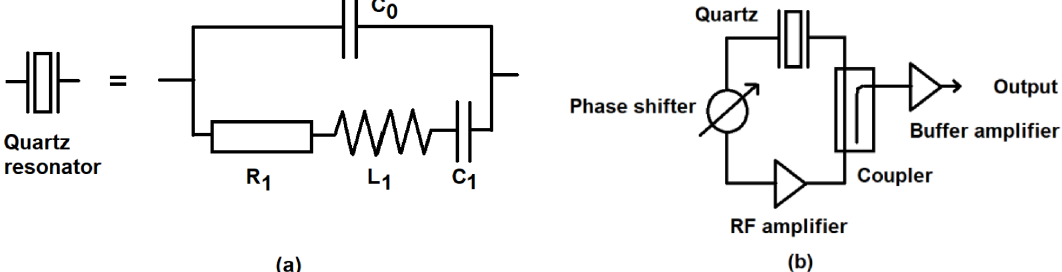
Figure 1. Principle of a quartz oscillator. A quartz crystal is equivalent to an electrical network with a low impedance in series and a parallel high impedance resonance. R1: resistance, L1: self, C0 and C1: capacitances. (a) Symbol and equivalent circuit of a quartz. (b) Quartz oscillator.